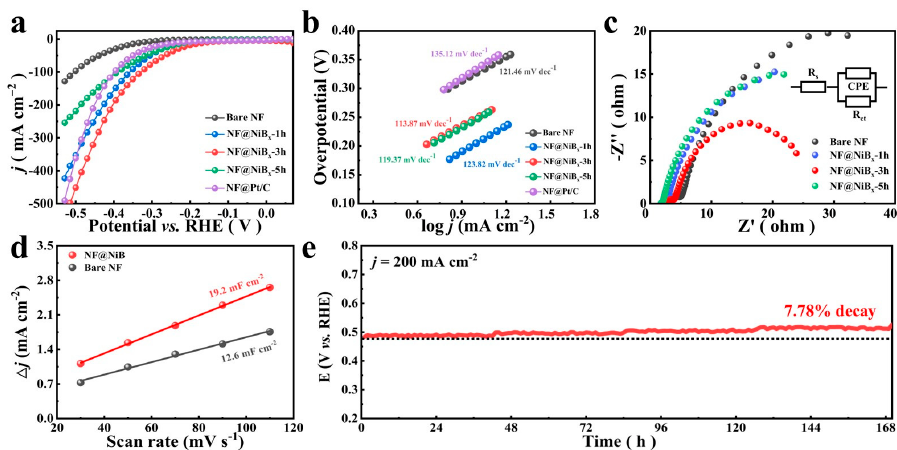
Figure 2. HER performance in 1 M KOH + 0.5 M NaCl solution: ( a ) LSV curves; ( b ) Tafel slopes; ( c ) Nyquist plots; ( d ) C dl values; ( e ) Chronopotentiometric measurement of HER at 200 mA·cm − 2 .